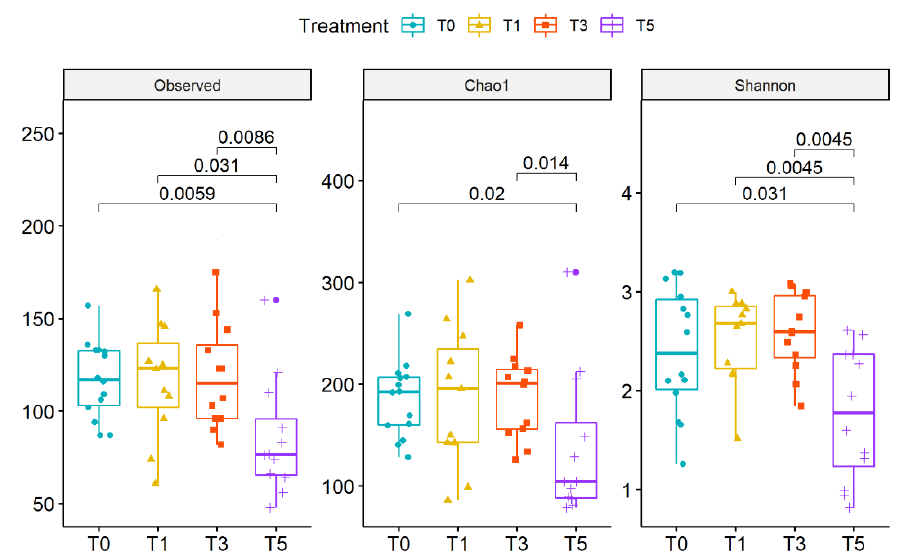
Figure 4. Boxplots representing alpha-diversity by Observed, Chao1 and Shannon indexes during the time-course for the CMA group. Boxes represent the median, 25th and 75th percentiles calculated for CMA group at T 0 (blue), T 1 (yellow), T 3 (red) and T 5 (purple). p -values are reported.